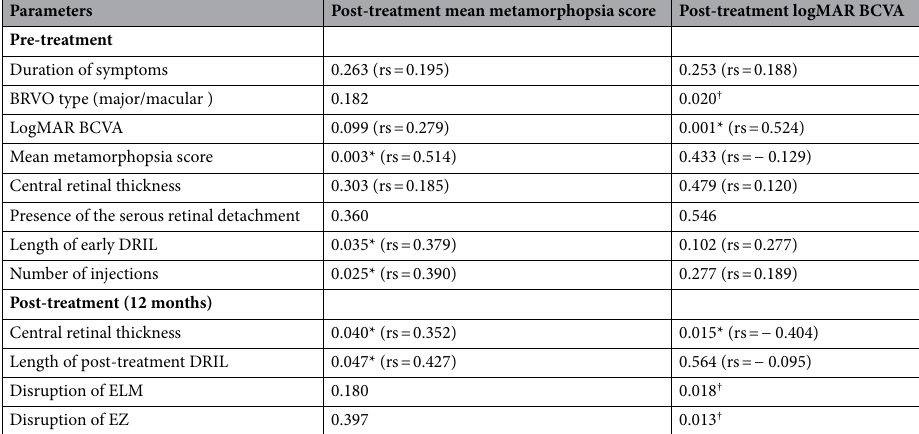
Table 2. Correlation between 12 months post-treatment visual functions and various parameters in patients with branch retinal vein occlusion ( P value). BRVO branch retinal vein occlusion, LogMAR logarithm of minimal angle of resolution, BCVA best-corrected visual acuity, DRIL disorganization of the retinal inner layers, ELM external limiting membrane, EZ: ellipsoid zone. *Significant correlations found between the parameters (Spearman’s rank correlation coefficient test). † Significant correlations found between the parameters (Mann–Whitney U test). rs = Spearman rank correlation